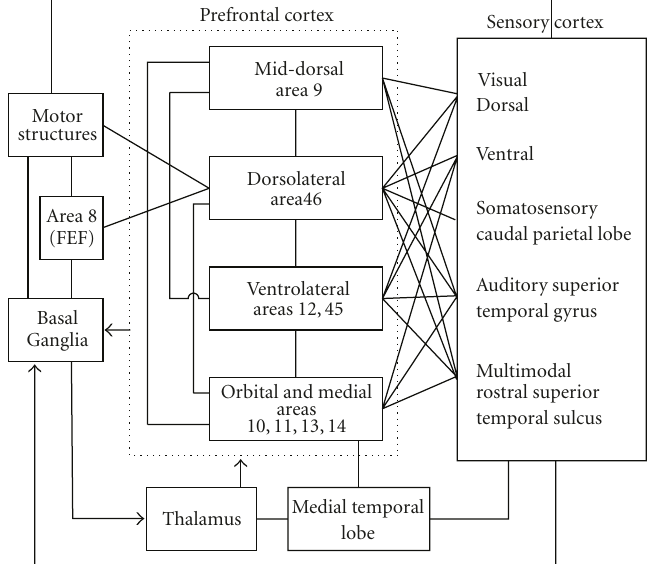
Figure 1: Schematic diagram of some of the extrinsic and intrinsic connections of the PFC. Most connections are reciprocal; the exceptions are indicated by arrows. The frontal eye field (FEF) has variously been considered either adjacent to or part of the